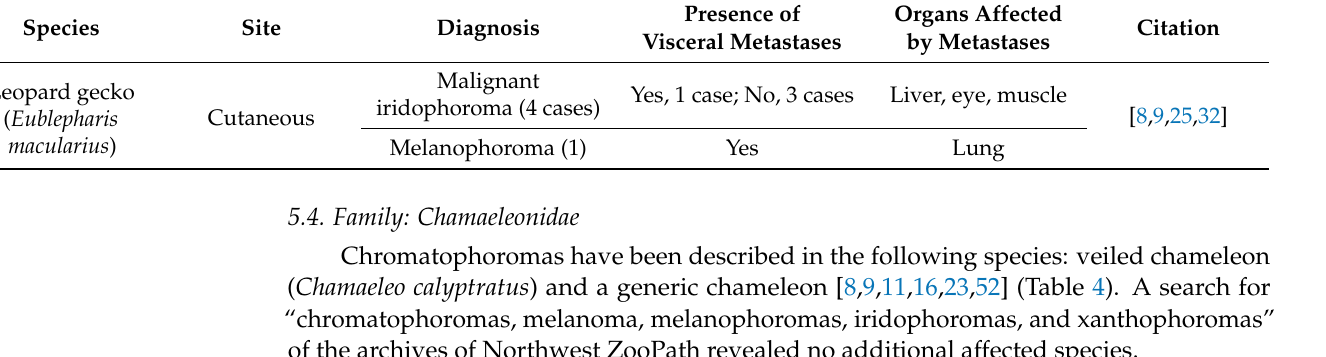
Table 4. Clinical features of chromatophoromas in the reptile family: Chamaeleonidae .